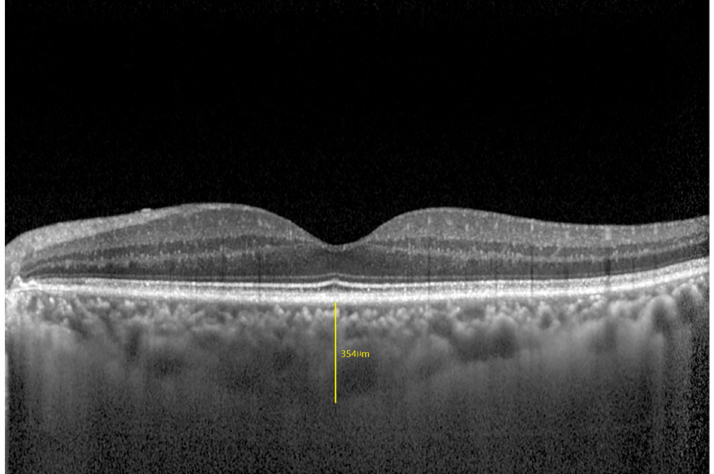
Figure 1. Subfoveal choroidal thickness measurement. The built-in software caliper tool was used to manually measure the vertical distance from the outer surface of the subfoveal retinal pigment epithe- lium (the highly reflective light band outside of Bruch’s membrane) to the sclerochoroidal